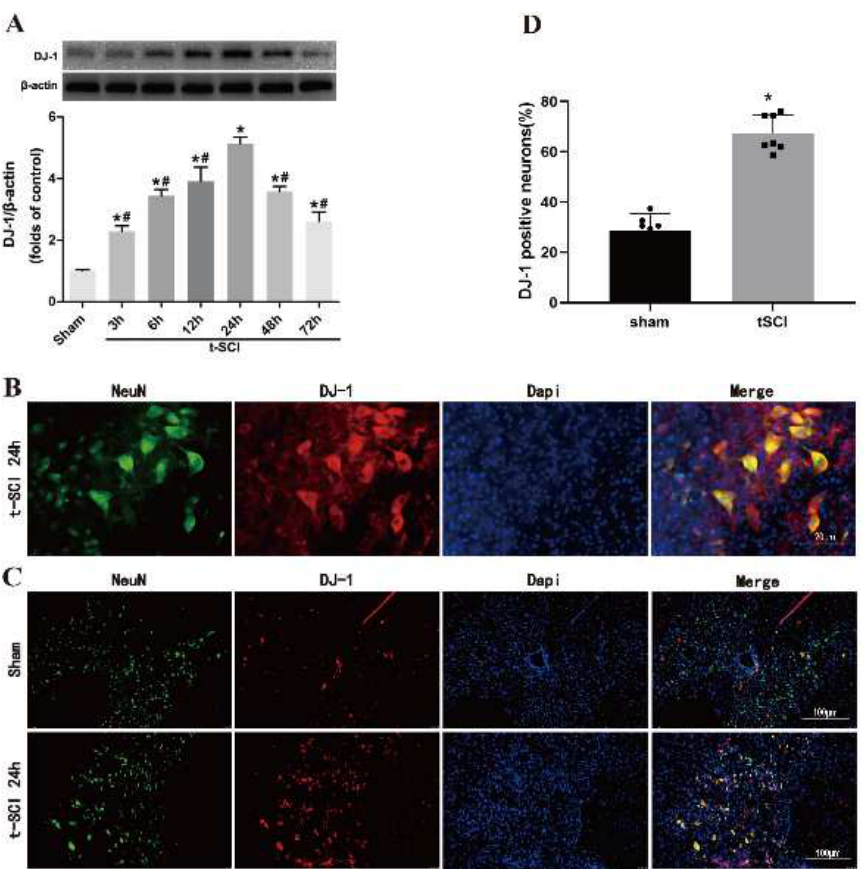
Figure 2. Temporal patterns and localization of DJ-1 after t-SCI. ( A ) Representative Western blotting of DJ-1 after t-SCI. ( B ) Representative immunofluorescence double staining micrographs showing the localization of S DJ-1. ( C , D ) The proportion of DJ-1-positive neurons in sham groups and after t-SCI. n = 6 for each group. * p < 0.05 vs. sham ; # p < 0.05 vs. t-SCI 24 h .